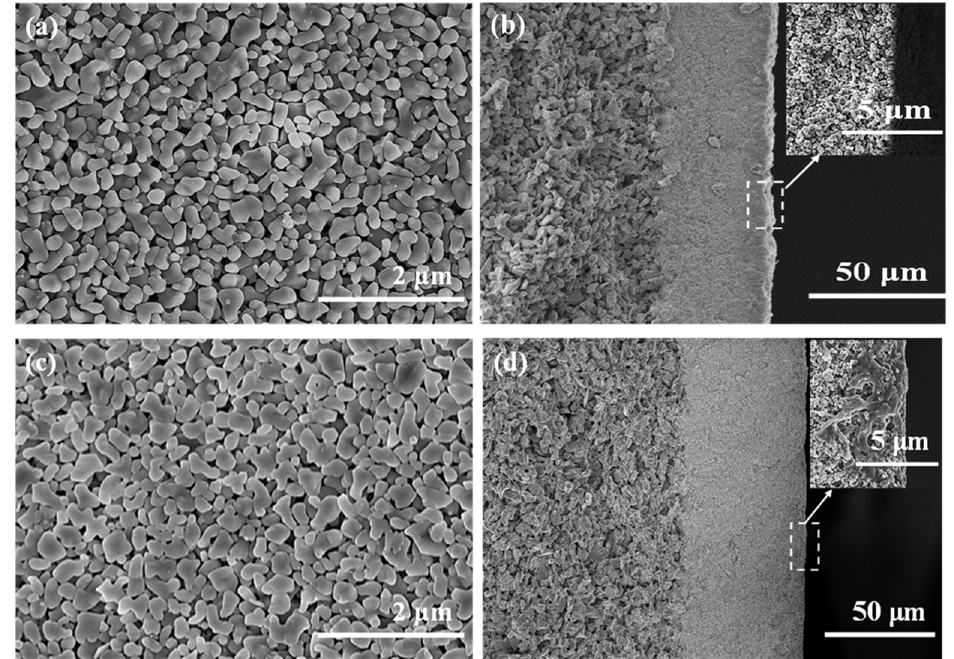
Figure 14. Field emission scanning electron microscope (FESEM) images of the α -Al 2 O 3 membrane before and after immersion in MEA solution. ( a ) surface and ( b ) cross-section of the unimmersed membrane; ( c ) surface and ( d ) cross-section of the immersed membrane.